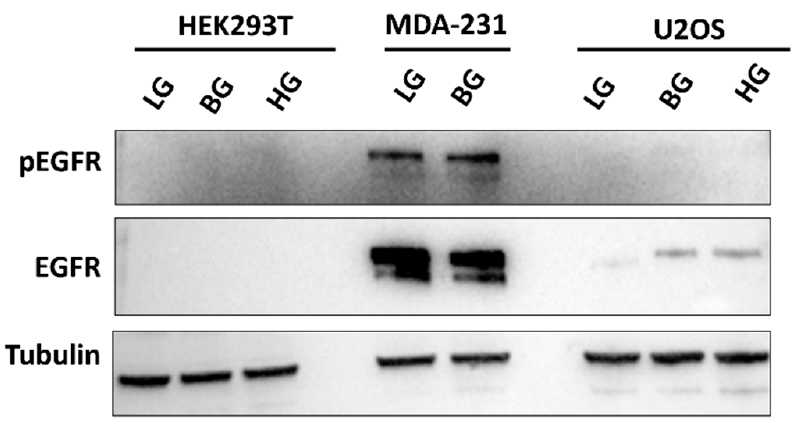
Figure 10. High expression of EGFR in MDA-MB-231 cells.Representative immunoblot of pEGFR (Y1068) and EGFR in HEK293T, MDA-MB-231, and U2OS glucose-adapted cell lines.